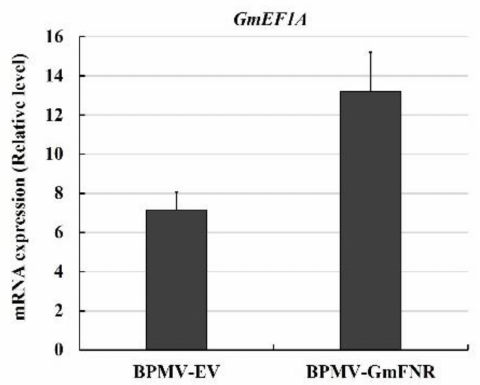
Figure 7. GmEF1A expression of control (BPMV-EV) and silencing (BPMV-GmFNR) plants. Bars indicate SD ( n =